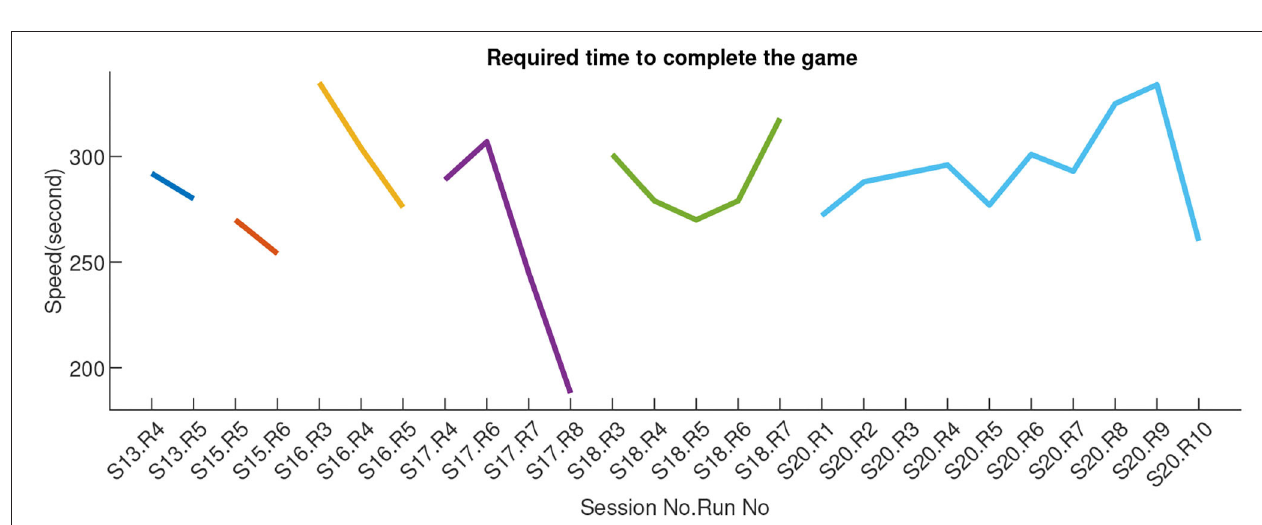
FIGURE 9 | Evolution of the proposed Test-Train Adaptation (TTA) metric over the runs in the transfer phase in different frequency bands.